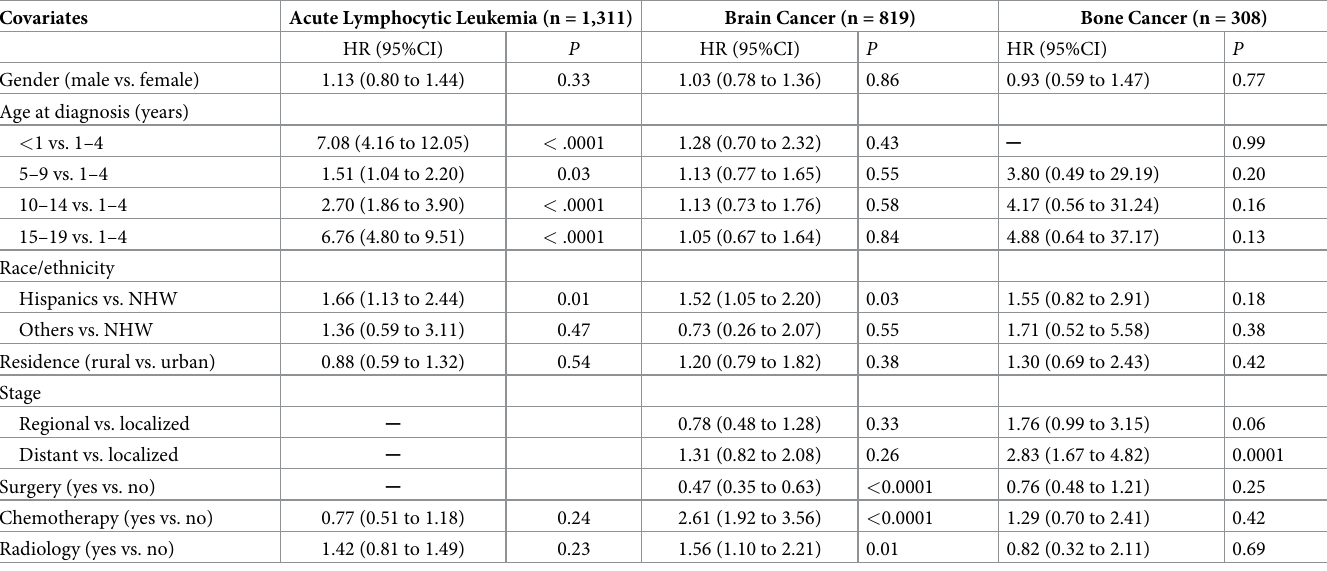
Table 4. Cox proportional survival multivariable-adjusted analyses a among the most three common South Texas childhood cancer diagnosis groups. Covariates Acute Lymphocytic Leukemia (n =